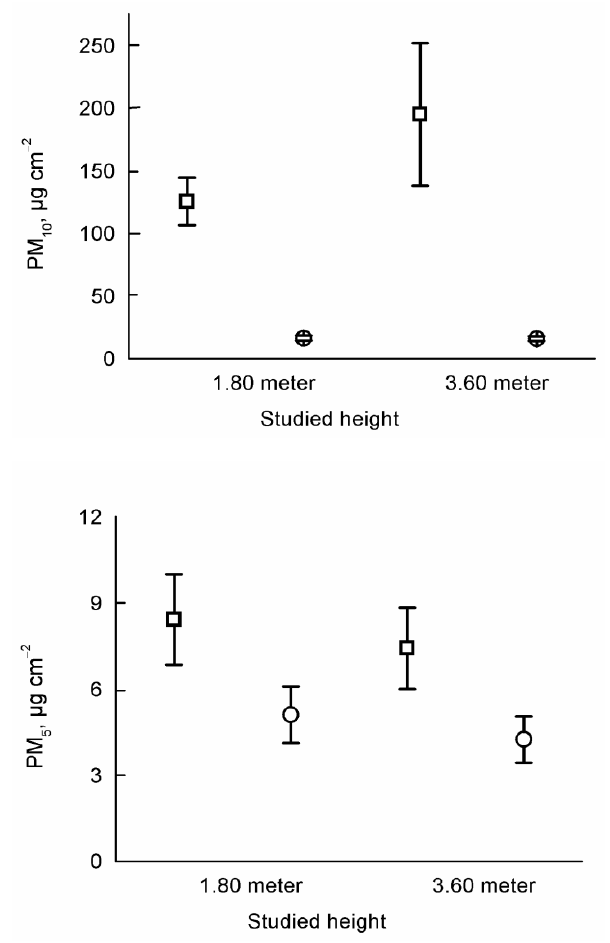
Figure 3. Average (± standard error) concentrations of PM in the different sampling heights. Notations: open square means PM 5 concentrations in traps, open circle means PM 5 concentrations on leaves.